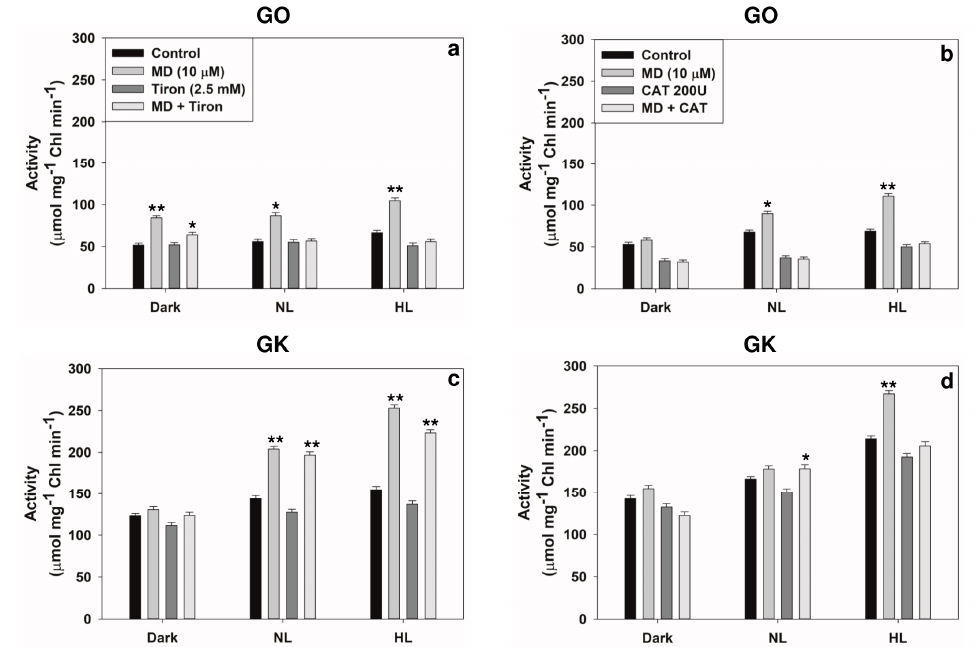
Figure 10. The consequence of scavenging superoxide (by Tiron) or H 2 O 2 by (catalase) on the activities of two key photorespiratory enzymes: glycolate oxidase (GO) ( a , b ) and glycerate kinase (GK) ( c , d ) in extracts from the leaf discs. * p < 0.05; ** p < 0.001.